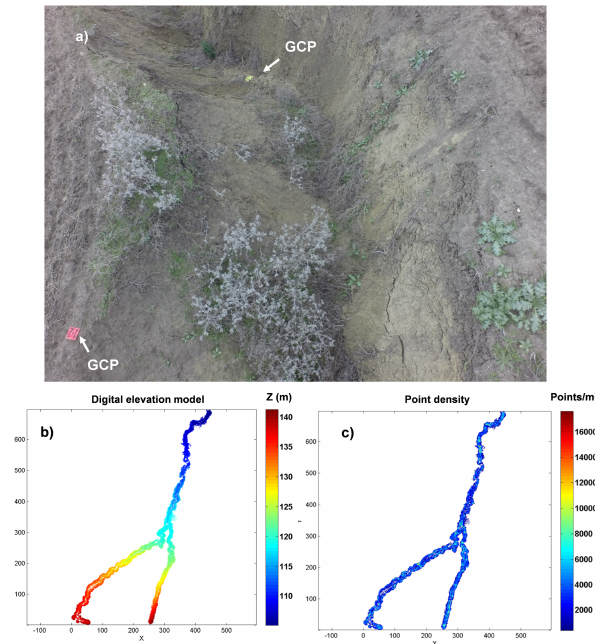
Figure 6. (a) View of gully branch 2 from the inclined camera showing two ground control points GCPs; (b) digital elevation model (m) and (c) point density map (pointsm − 2 ) for the entire gully network from SF3M results. Several gaps in the 3-D model can be noticed as a result of vegetation occlusion, mainly small green weeds (removed by the green index filter) and tall grey weeds (filtered by applying the point classification by CANUPO).